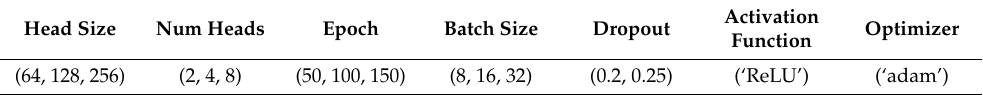
Table 3. Hyperparameter range for the selection of the best Transformer